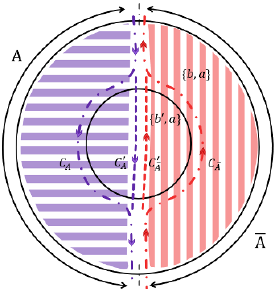
Figure 33 . Schematic plot of (cid:12)nal state of the greedy algorithm when (cid:20) c < (cid:20) UV . The thick- 1 ness of the region which is not absorbed by the greedy algorithm decreases in the IR